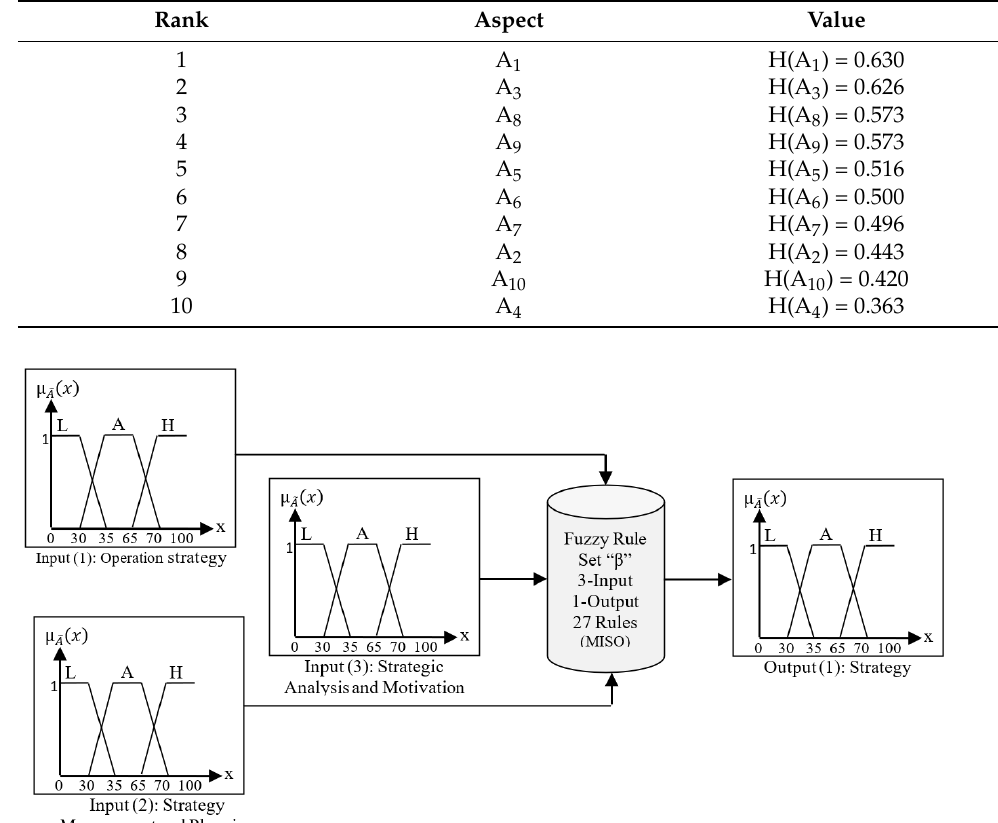
Figure 7. Multi-factor fuzzy inference system for strategy aspect (output 1) .